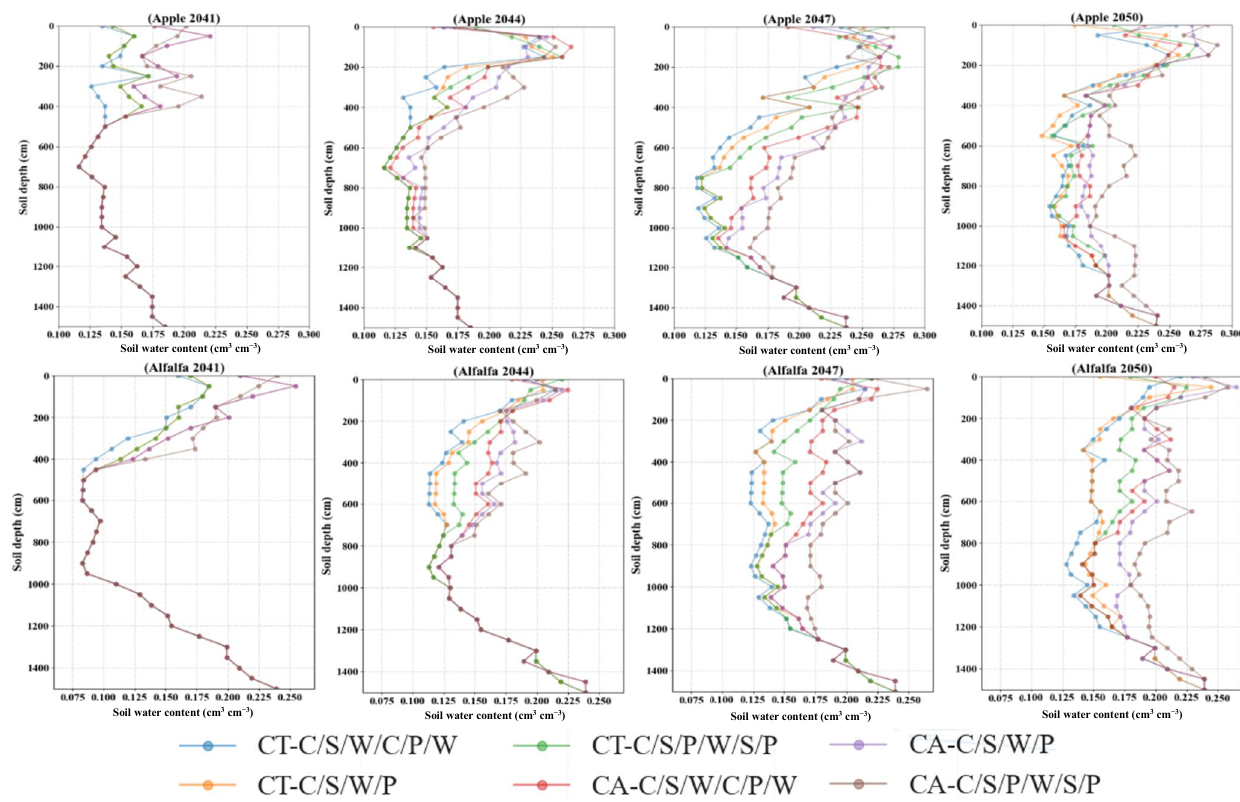
Figure 8. Soil water content (cm 3 cm −3 ) profiles of the 0–15 m in conventional tillage and conservation agriculture. During the process of DSL restoration, the change of soil available water (SAW)